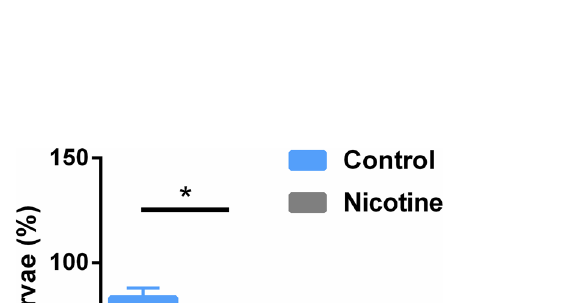
Figure 2. E-nicotine exposure decreases the number and size of the eggs. ( a ) The number of eggs (%) collected per 2 h per group ( b ) Quantification of the egg length (mm) ( c ) Representative stereomicroscope image of the eggs laid on grapefruit agar (GA) per 2 h per group analysed using the image software cellSens (red line represents the measurement of the egg length). Values are mean ± SEM, unpaired t-test, **p ≤ 0.01. Bar represents 200 μm, n = 3 independent experiments.